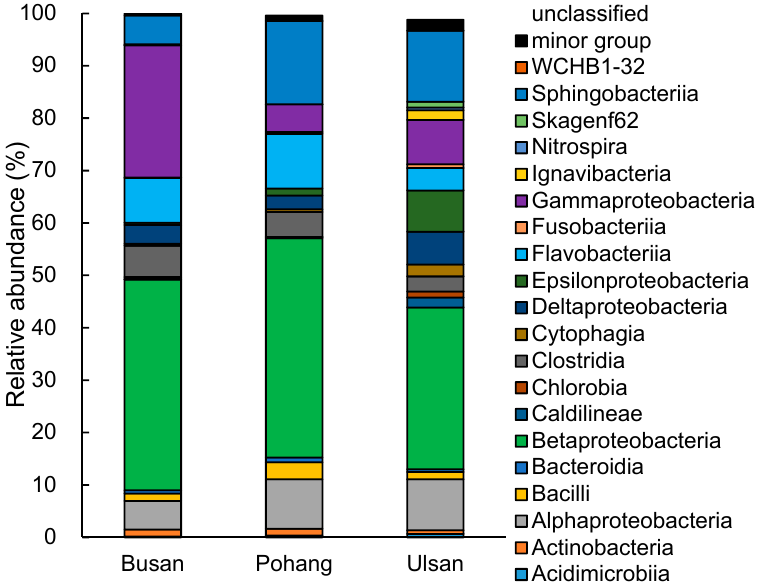
Figure 4. Relative abundance (%) of bacterial classes found in secondary sludge from WWTPs in Busan, Pohang, and Ulsan.